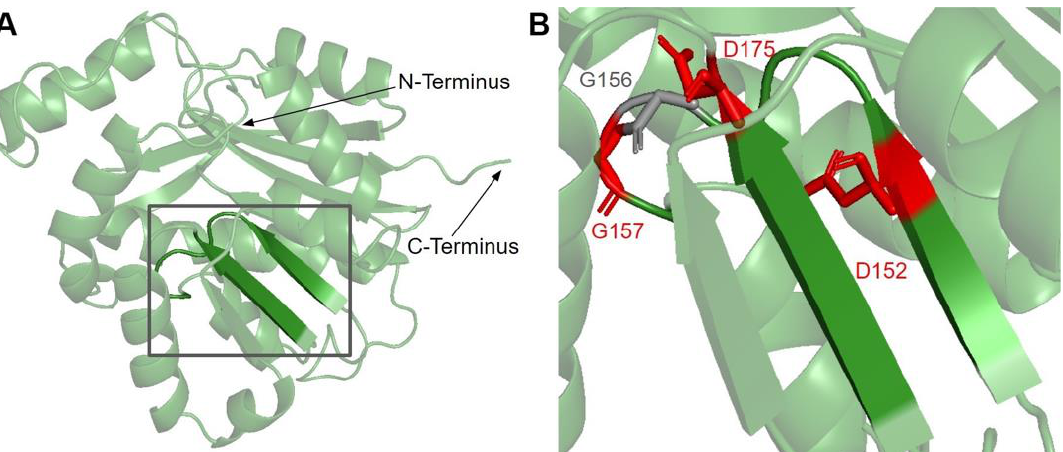
Figure 6. SNVs found in motifs I and post I of COQ3. ( A ) Motifs I (right β -strand and loop, residues I150 to G1158) and post I (left β -strand, residues V171 to D175) highlighted on residues 91 – 336 of the COQ3 model. N- and C-termini were truncated for simplicity. ( B ) Locations of SNVs in motifs I and post-I are depicted. Residues are colored according to their corresponding SNVs in Figure